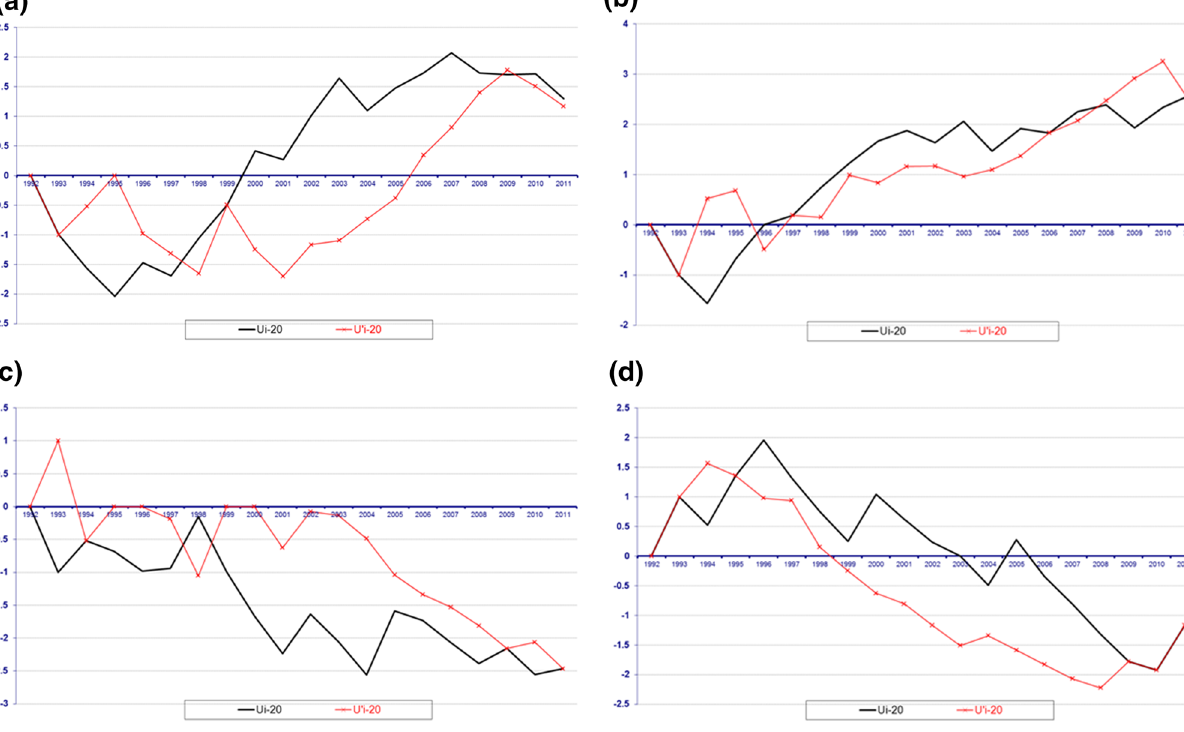
Fig. 5 Mann–Kendall plot of quality parameter for Dehnu station, a Ca, b Cl, c So 4 , d